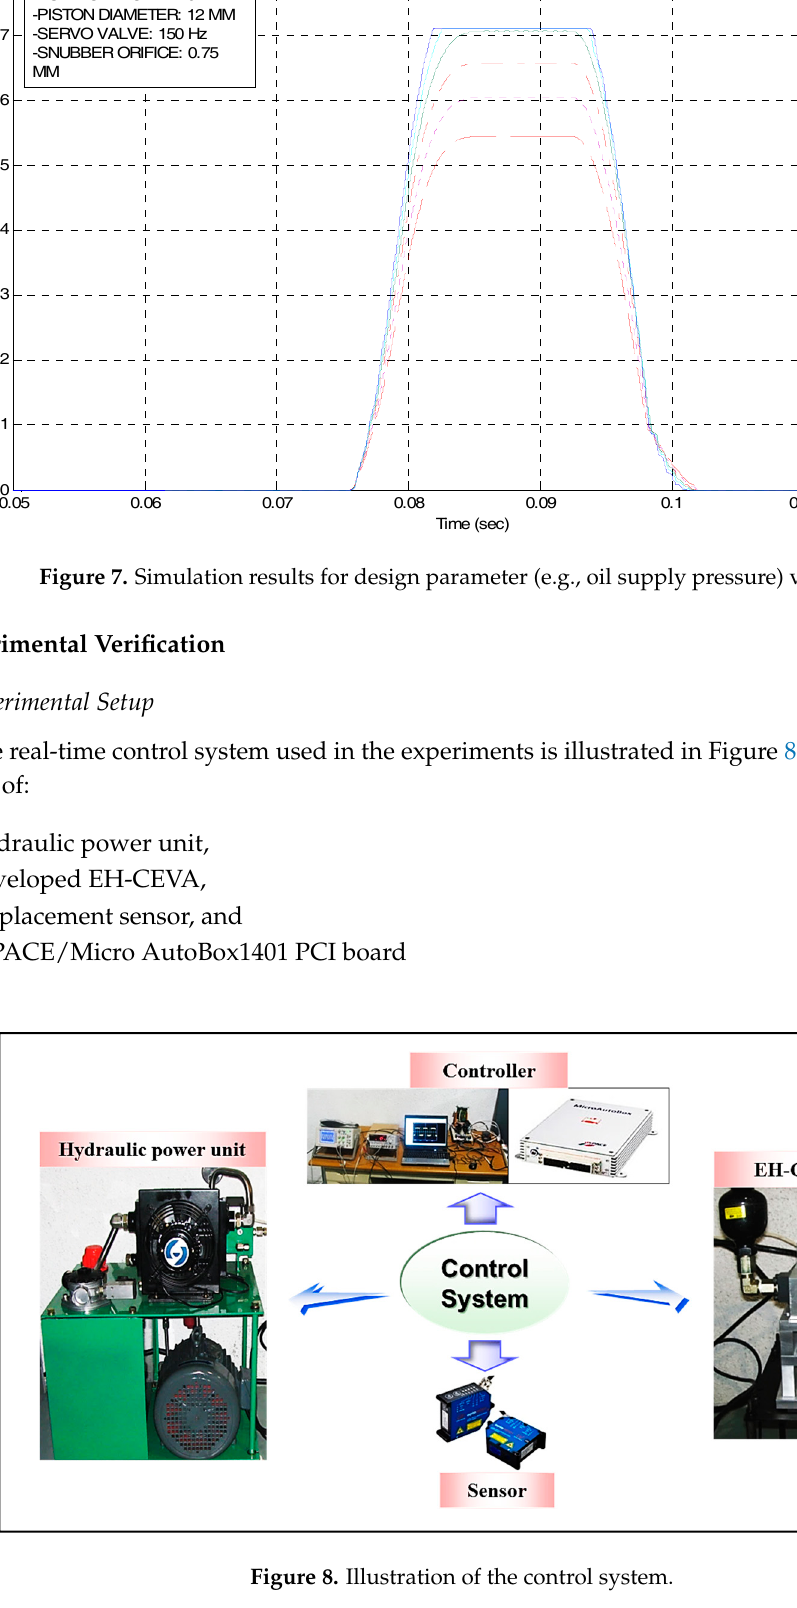
Figure 6. Simulation results for design parameter (e.g., piston diameter) variation.